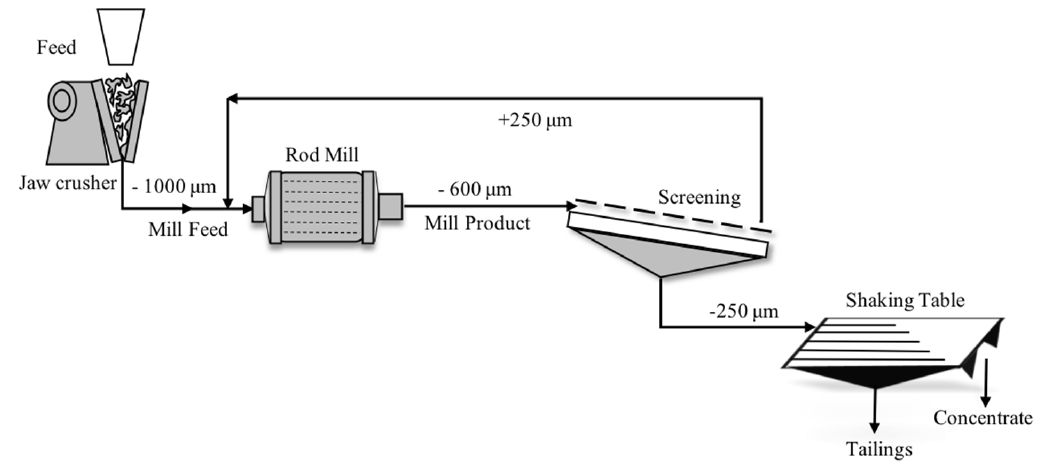
Figure 1. Schematic diagram of the work conducted in the